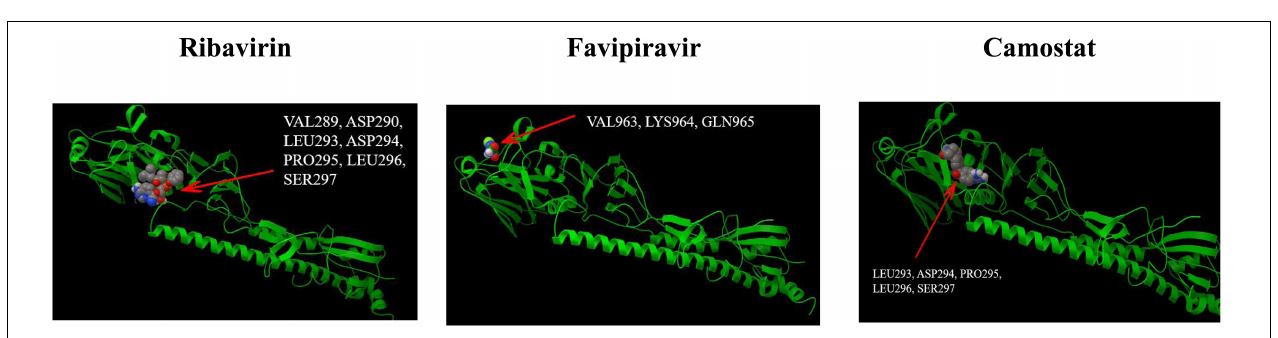
FIGURE 4 | The binding mode between the four drugs docked with molecules and the receptor HEMAGGLUTININ (PDB ID: 2VIU).